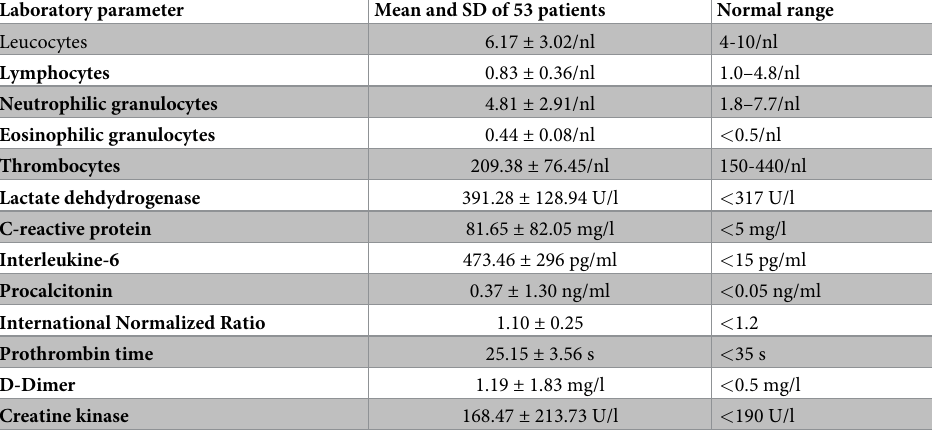
Table 2. Mean and standard deviation of the laboratory parameters of all 53 COVID-19 patients.